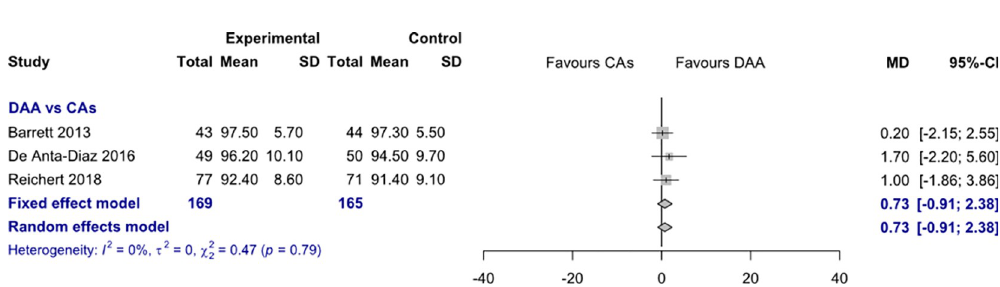
Fig 8. Comparison of the HHS 12 months postoperatively. DAA, direct anterior approach; CAs, conventional approaches; SD, standard deviation; MD, mean difference; CI, confidence interval.